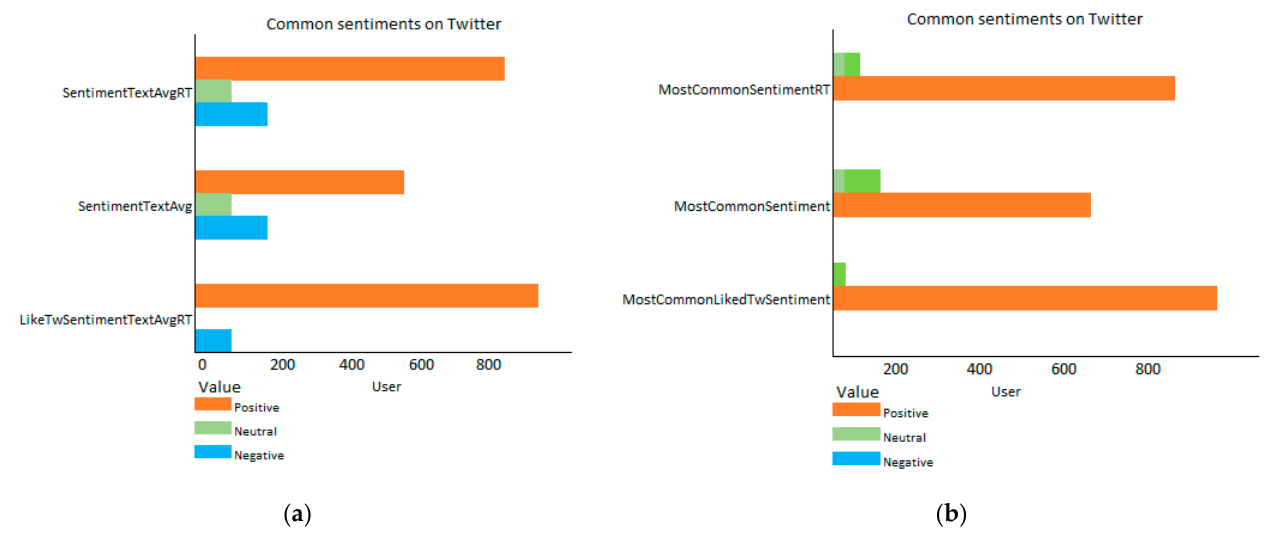
Figure 2. Sentiment analysis and category identification: ( a ) shows the average of mixed feelings by category of tweets; ( b ) presents the common sentiments by category of